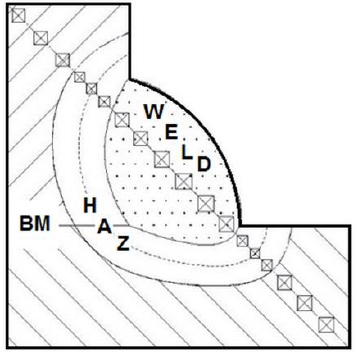
Figure 11. Scheme of microhardness evaluation on fillet